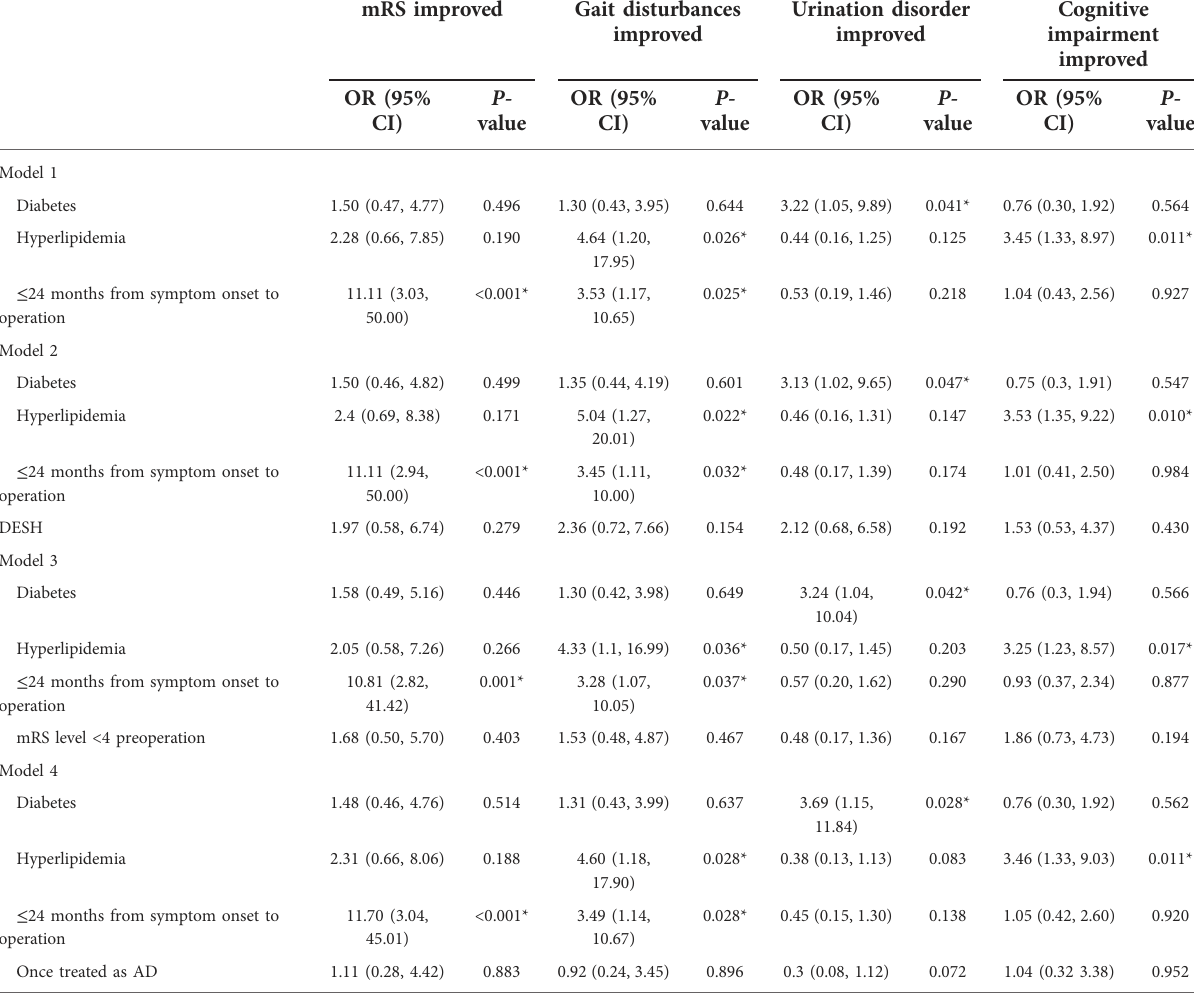
TABLE 5 Multivariate logistic regression analysis of functional and symptom improvements at 1 year after